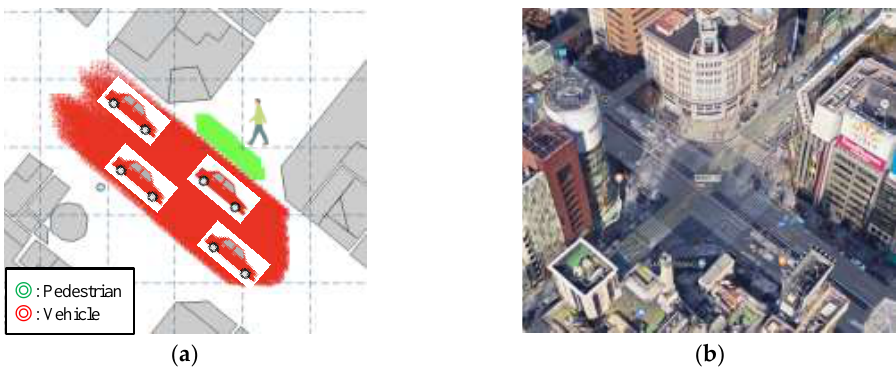
Figure 7. Evaluation scenario. ( a ) Placement of a moving pedestrian and vehicles. ( b ) The aerial photograph of the simulation map (Ginza 4-chome intersection).